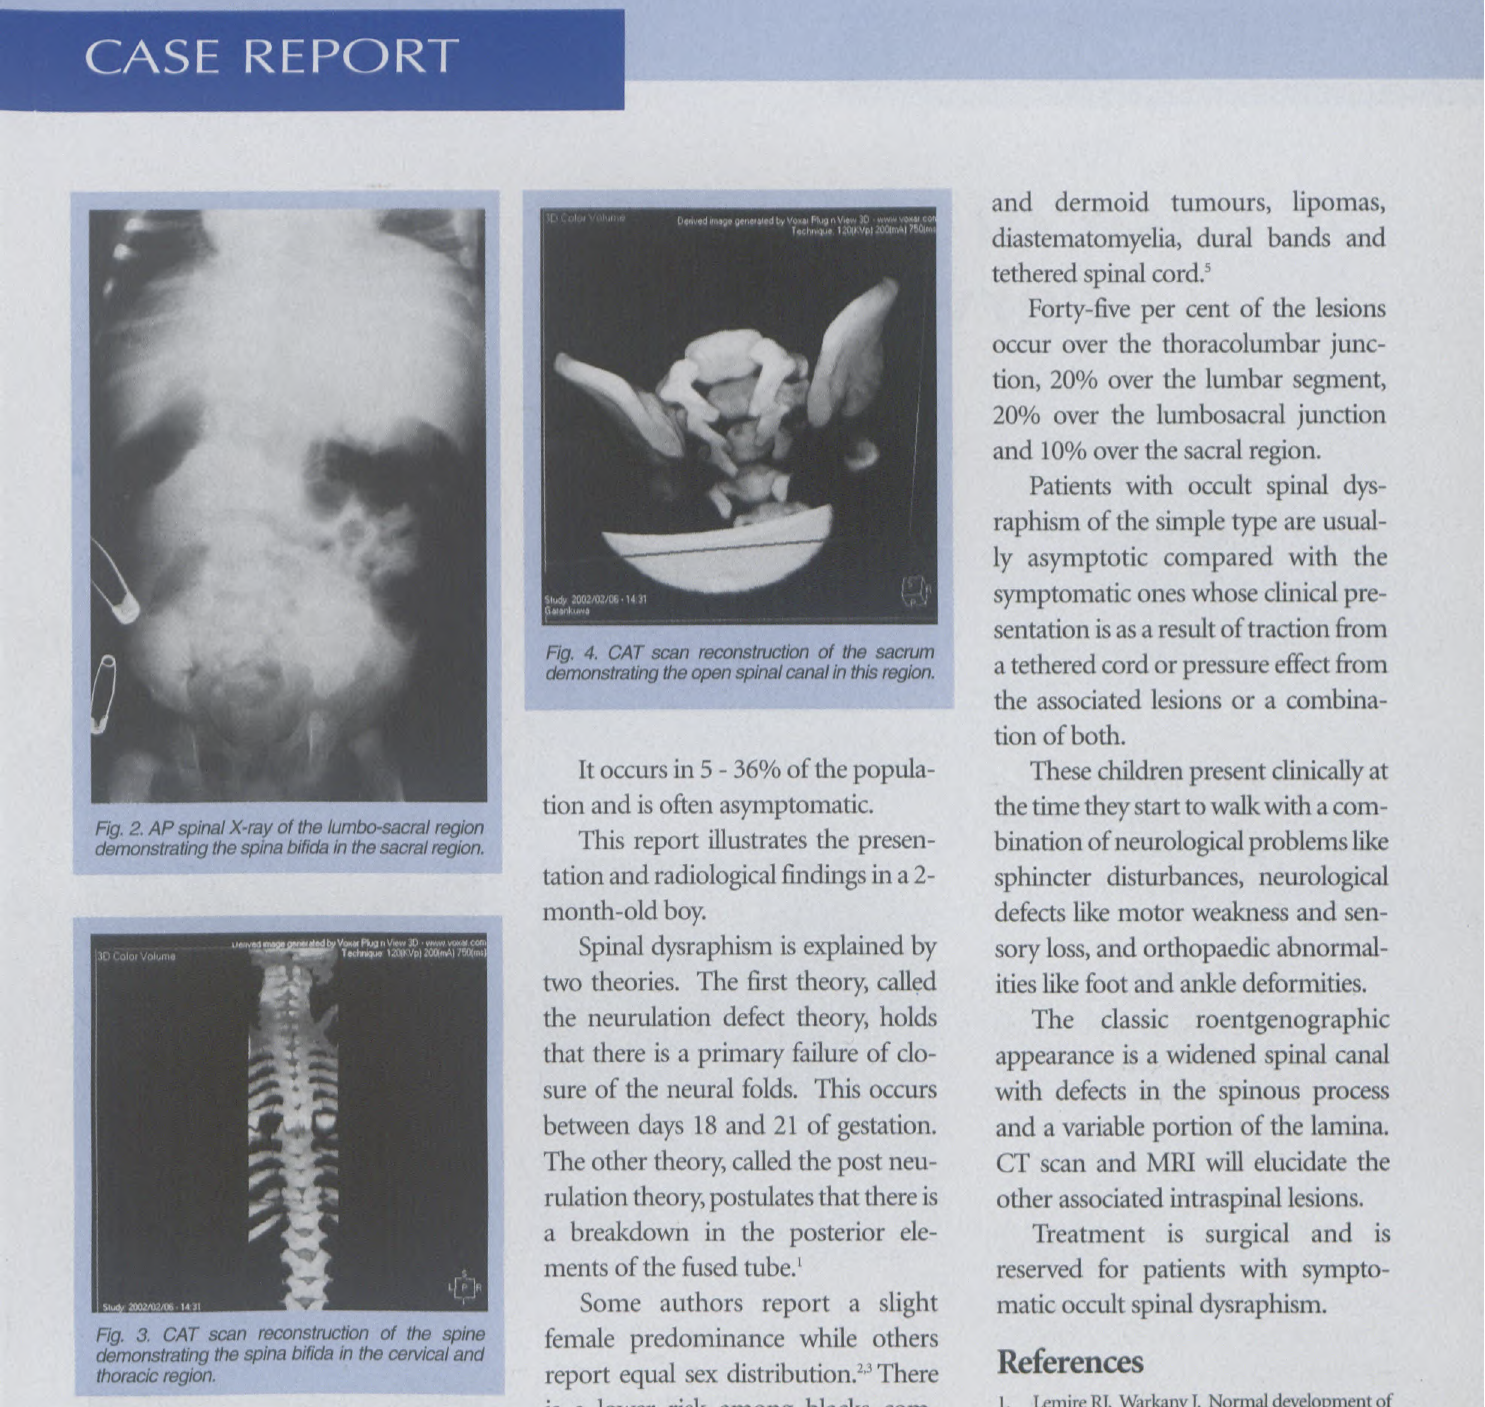
Fig. 3. CAT scan reconstruction of the spine demonstrating the spina blfida in the cervical and thofacic region.